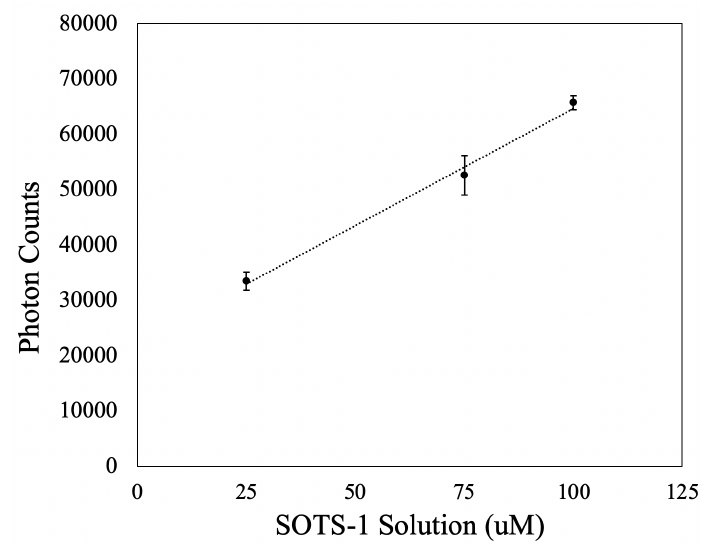
Figure 6. There is a linear relationship between the raw photon count and the concentration of the SOTS-1 solution. The error bars highlight the range in photon counts observed across the duplicate